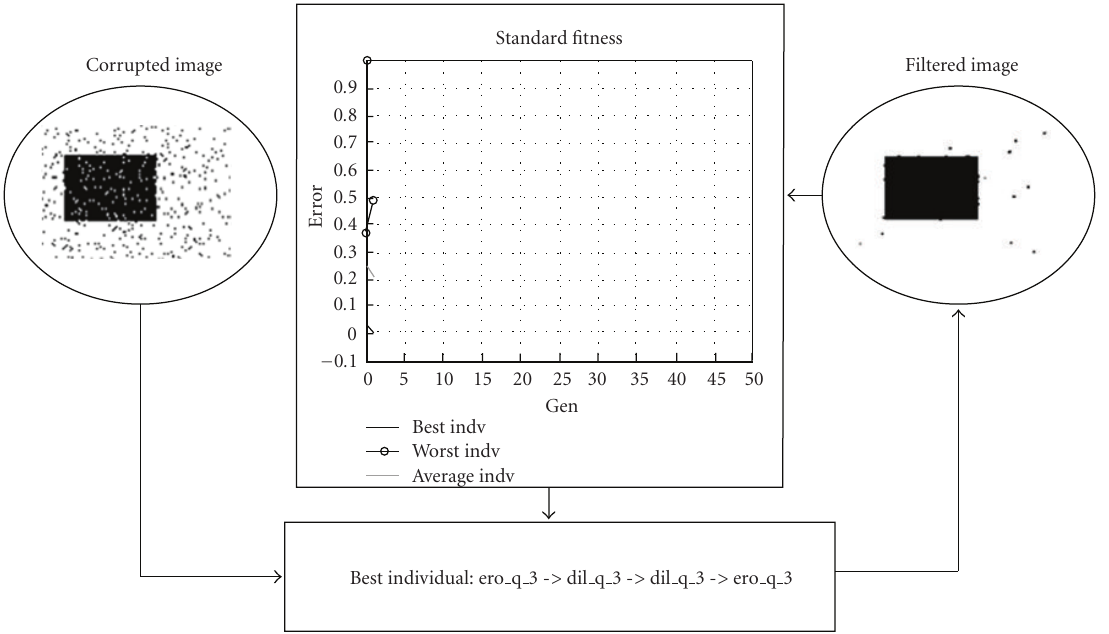
Figure 10: Automatically generated filter to eliminate the salt and pepper noise from the corrupted original image.